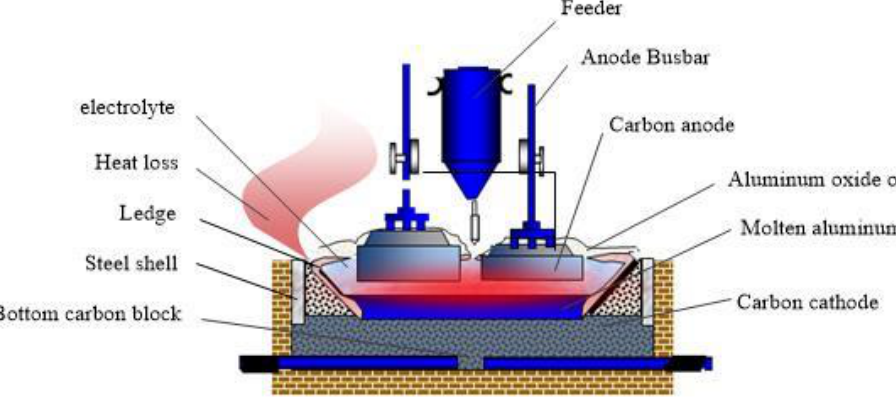
Figure 1. The schematic of aluminum electrolytic cell.